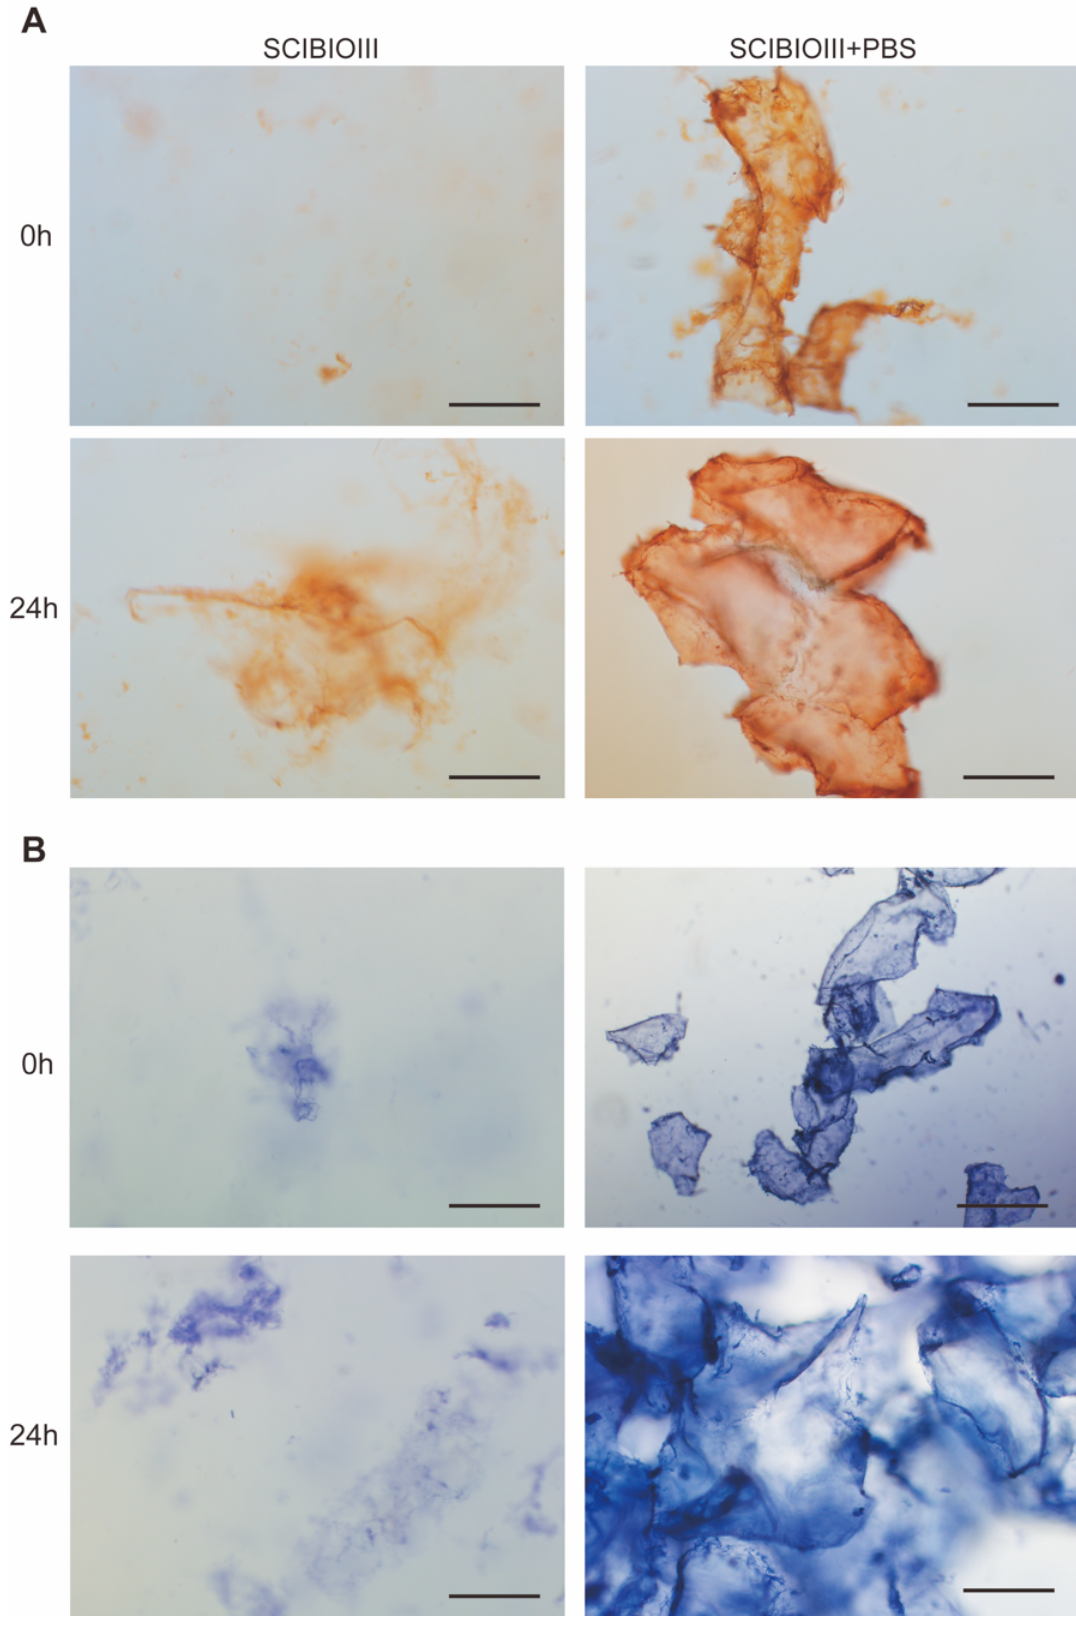
Figure 2. Congo red/aniline blue staining analysis. ( A ) Congo red staining results of SCIBIOIII at 0 h and 24 h; ( B ) aniline blue staining results of SCIBIOIII at 0 h and 24 h. Scale bar: 200 µm.